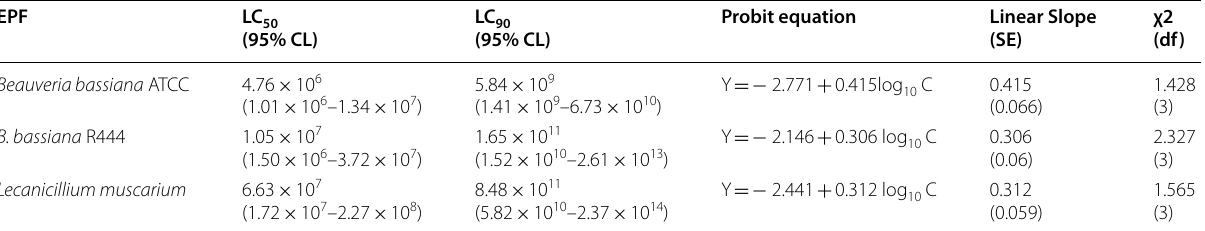
CL confidence limit which has been calculated with 95% confidence